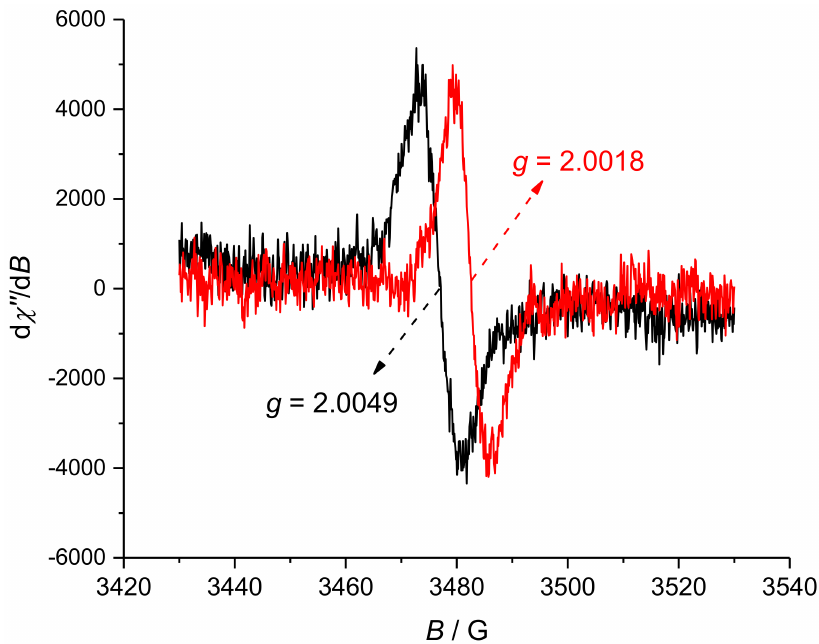
Figure 4. EPR spectra of the 1e-reduced 9 (Ni − Zr) (black trace) and 1e-oxidized 9 (Ni − Zr) (red trace) in ACN/ n -Bu 4 NPF 6 .